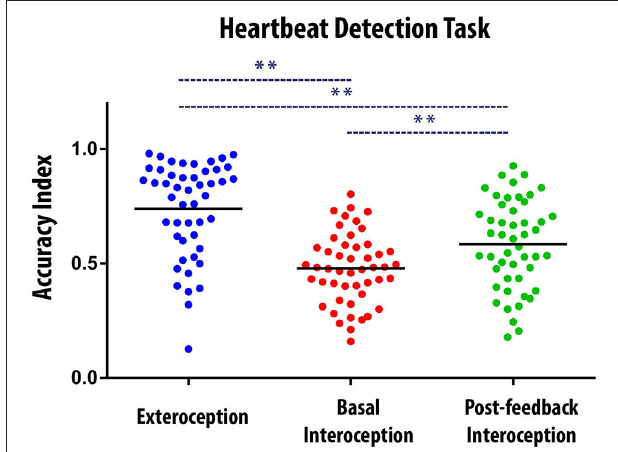
FIGURE 1 | Behavioral results of the Heartbeat Detection (HBD) task. Dots show the mean performance of each subject for each condition (i.e., the average of the two blocks of each condition). The Accuracy Index can vary between 0 and 1, with higher scores indicating better interoceptive accuracy. ** Indicates significant differences between the conditions, set at p < 0.05. The black bars indicate the mean of the data distribution.